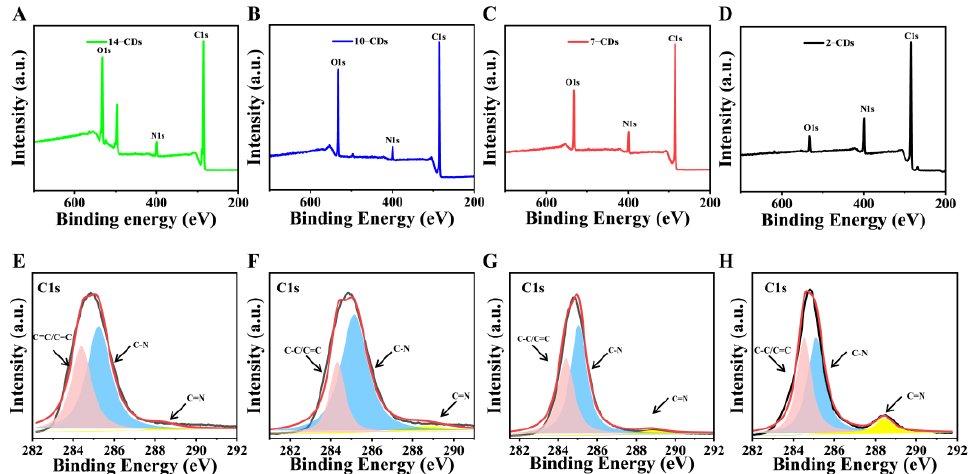
Figure 5. XPS survey spectrum of the ( A ) 14–CDs, ( B ) 10–CDs, ( C ) 7–CDs and ( D ) 2–CDs (the main peaks of C1s, N1s and O1s for the four CDs). High-resolution C 1 s of the ( E ) 14–CDs, ( F ) 10–CDs, ( G ) 7–CDs and ( H ) 2–CDs (pink, blue and yellow represent C − C/C=C, C − N and C=N, respectively).